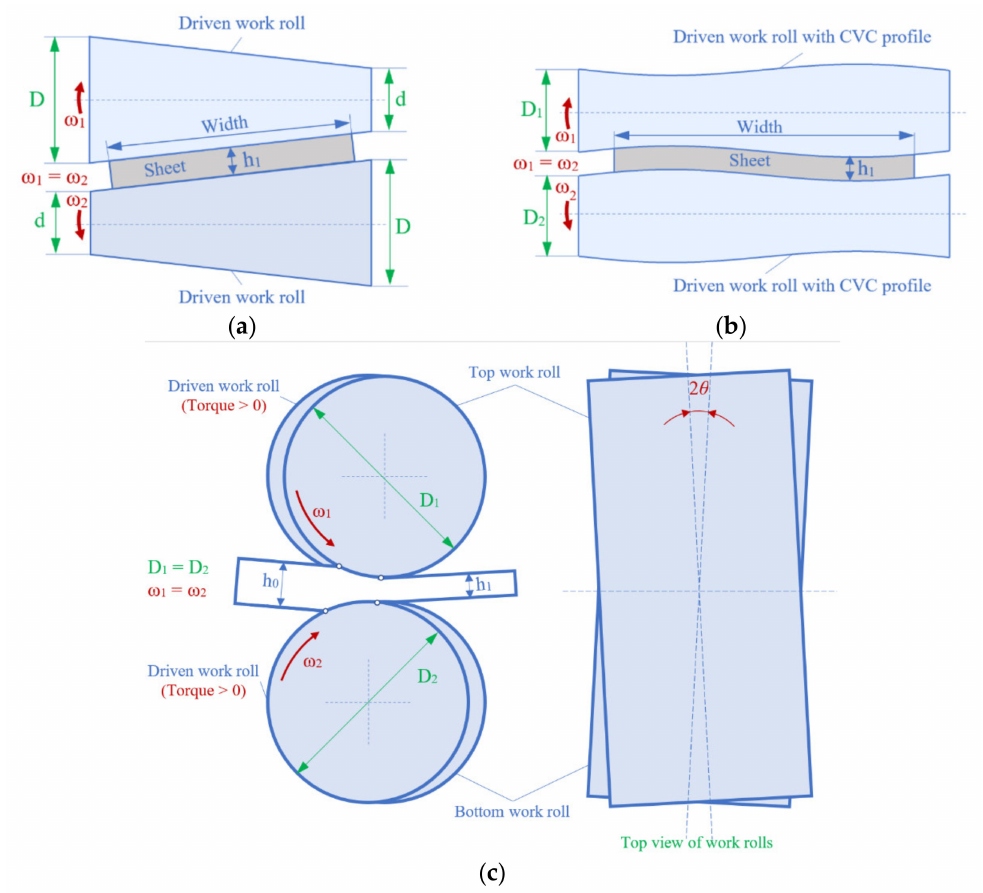
Figure 3. Schematic illustration of asymmetric rolling processes with purposefully created asymmetry in the horizontal plane along the width of the deformation zone: ( a ) Rolling with cone-shaped work rolls; ( b ) rolling with CVC work rolls; ( c ) rolling with crossed work